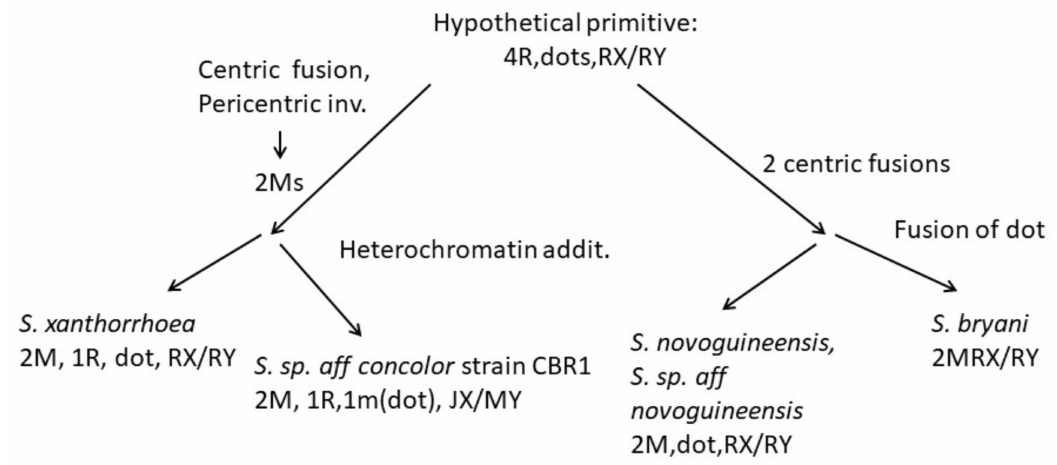
Figure 11. Possible karyotypic changes giving rise to other Scaptodrosophila species studied. Further arm reduction is observed in S. novoguineensis and S. sp. aff.